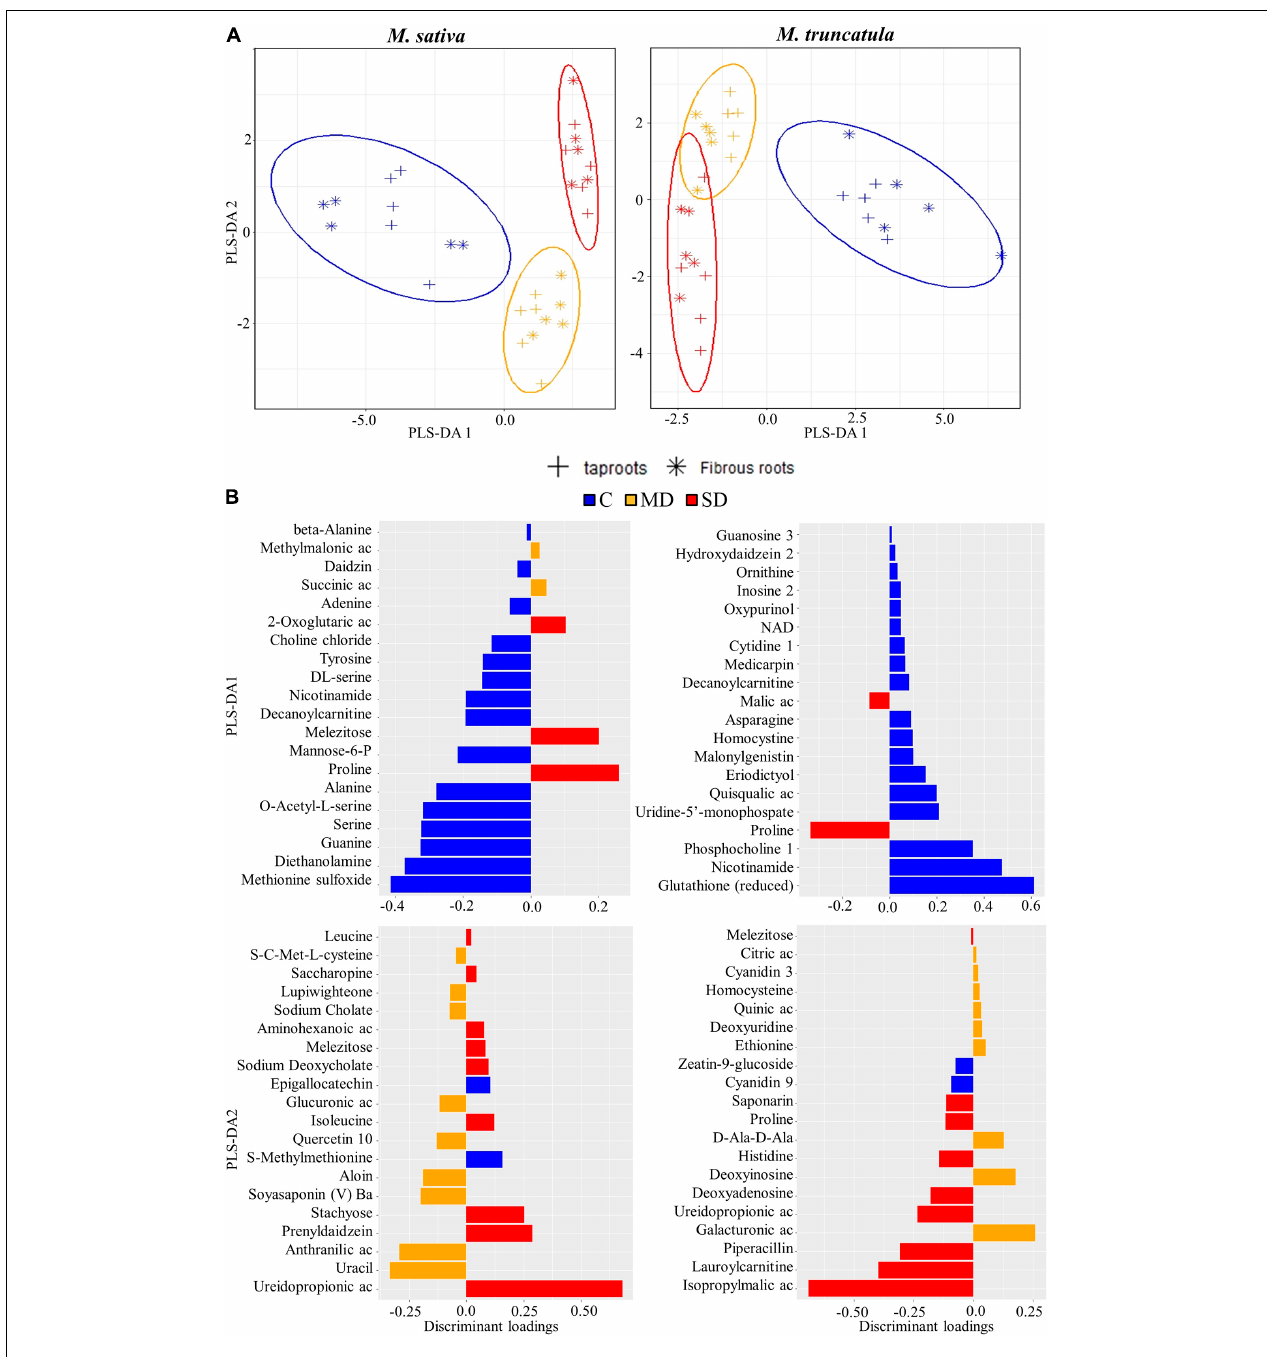
FIGURE 2 | Identification of metabolites most affected by water deficit. (A) Partial least square discriminant analysis (PLS-DA) of metabolites in Medicago sativa (left panel) and M. truncatula (right panel). (B) Metabolites with the highest discriminant loadings for control (C), moderate water deficit (MD), and severe water deficit (SD) treatments. Ac, acid; NAD, nicotinamide adenine